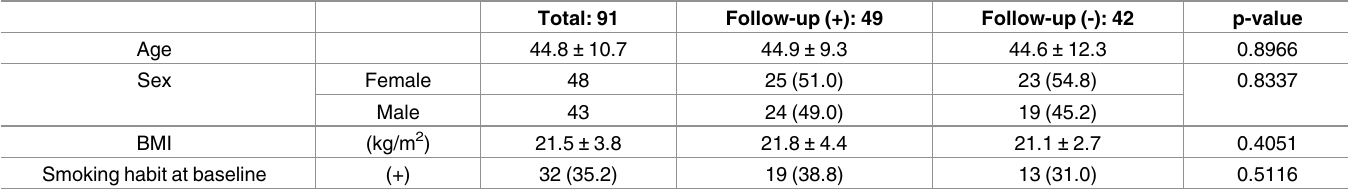
Table 2. Demographic data of the participants who did and did not participate in the follow-up